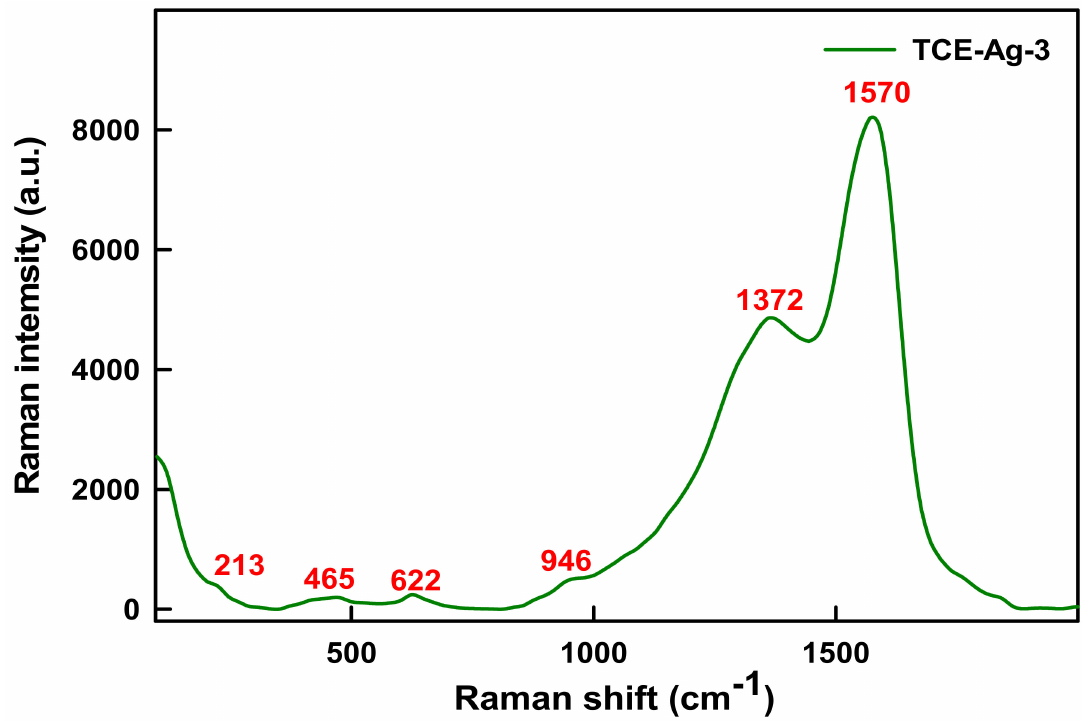
Figure 3. Raman spectroscopic analysis of TCE bio-actives plausibly capped of TCE-Ag-3. Table 1. Band positions from TCE-Ag-3 colloidal solution at 785 nm laser wavelength.